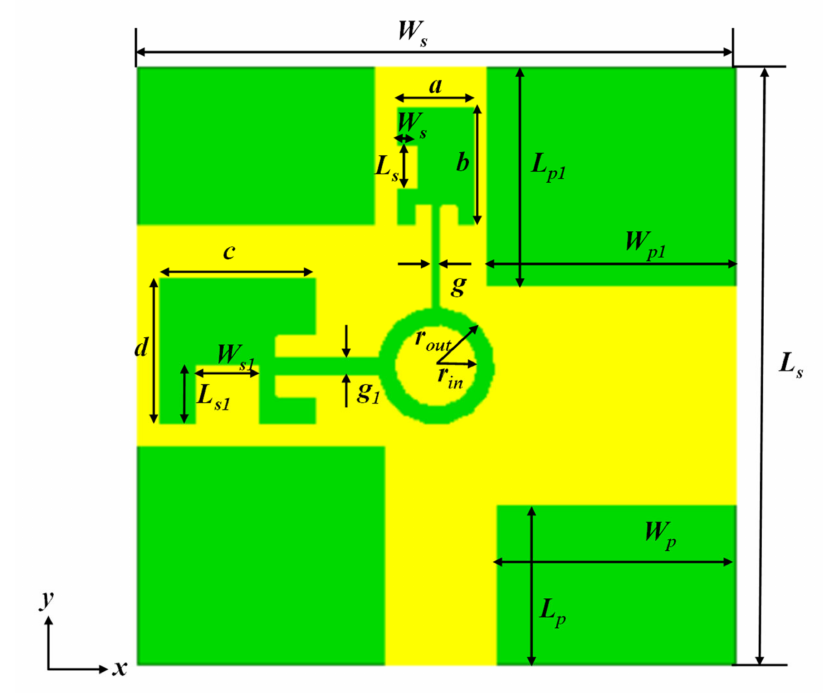
Figure 2. Single-port pentaband antenna geometry. Table 2. Geometrical parameters of the single-port